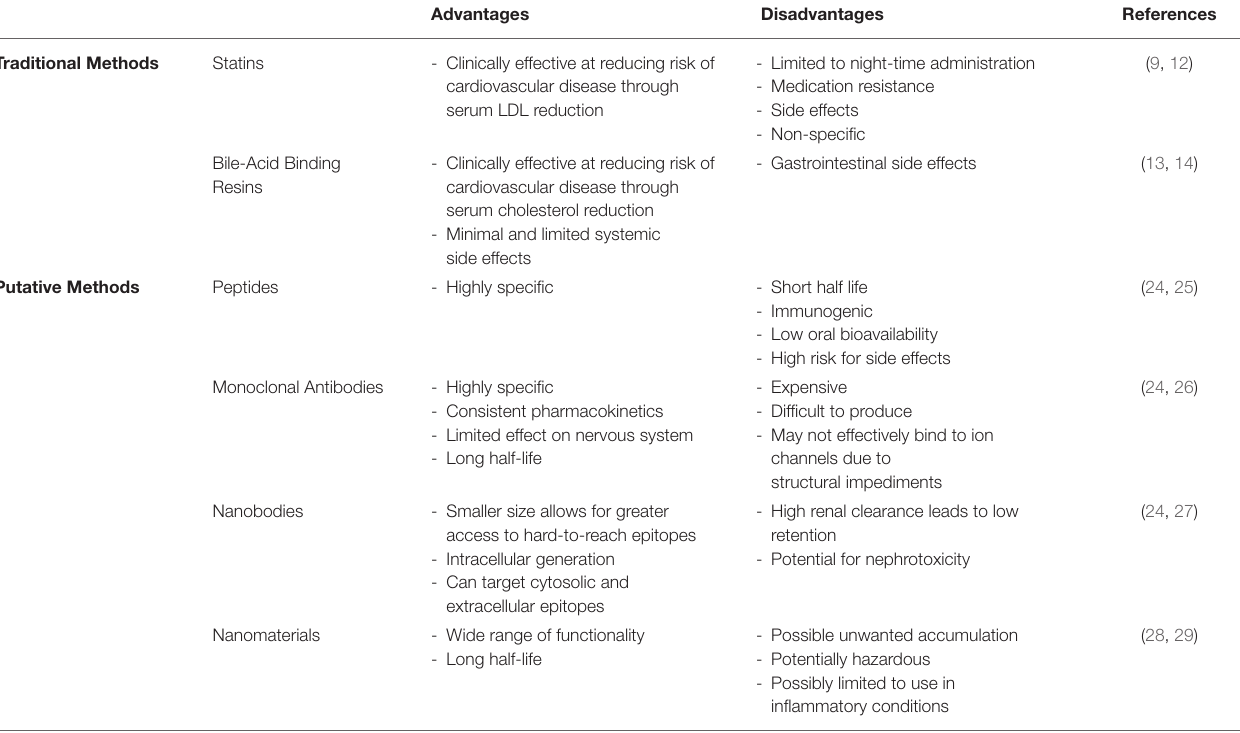
TABLE 1 | Traditional vs. putative methods of targeting lipid-ion channel